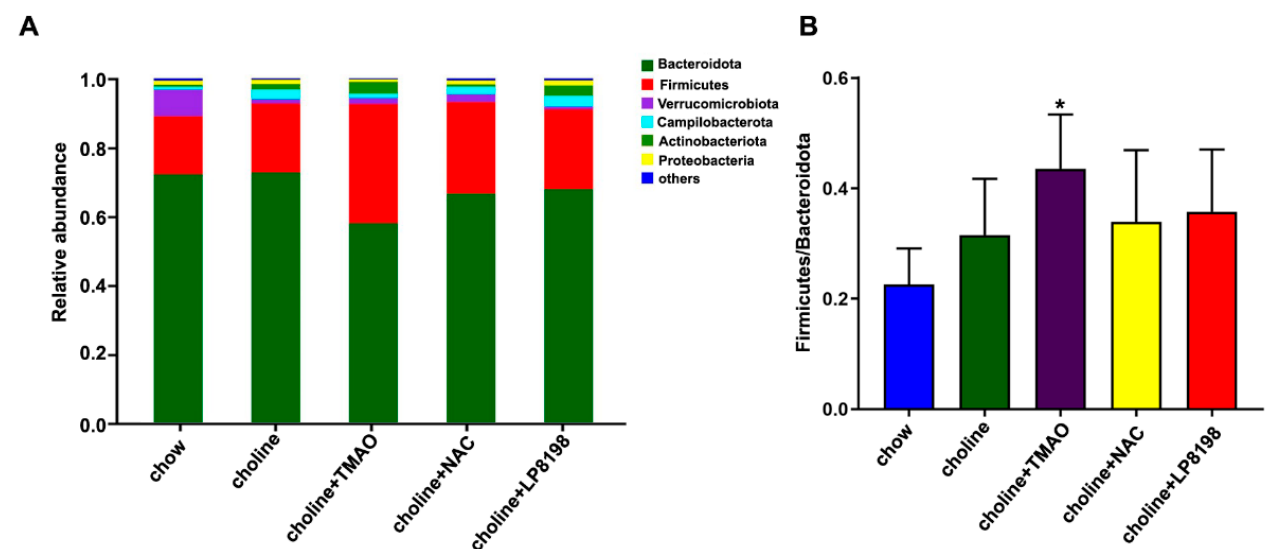
Figure 8. A choline diet alters the composition of the intestinal microbiome. ( A ) Composition and relative abundances of bacterial phyla in different groups. ( B ) The ratio of Firmicutes/Bacteroides in different groups. Values are the mean ± SD; n = 5 per group; two-way ANOVA followed by a Tukey post hoc test. * p < 0.05 vs. the chow group.